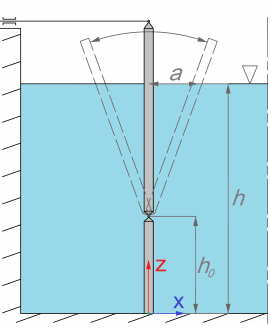
Figure 2. The flap-type wave maker considered under the